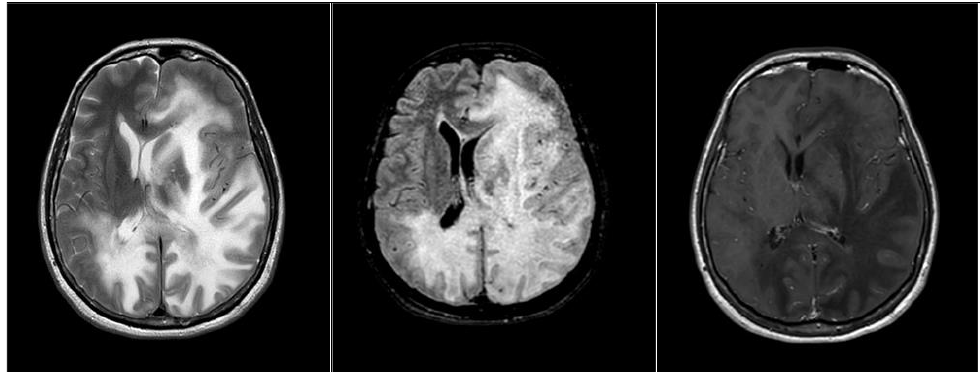
Figure 3. The signal alteration involved both the cerebellar lobes and the structures of the brain stem in the subtentorial site, and the left hemisphere with extension to the capsule nucleus region, causing a significant mass effect on the ipsilateral ventricular hemisystem and consequent shift of the structures of the midline. The pathological process, which also extends contralaterally in the right hemisphere, does not present areas of pathological enhancement in the context.